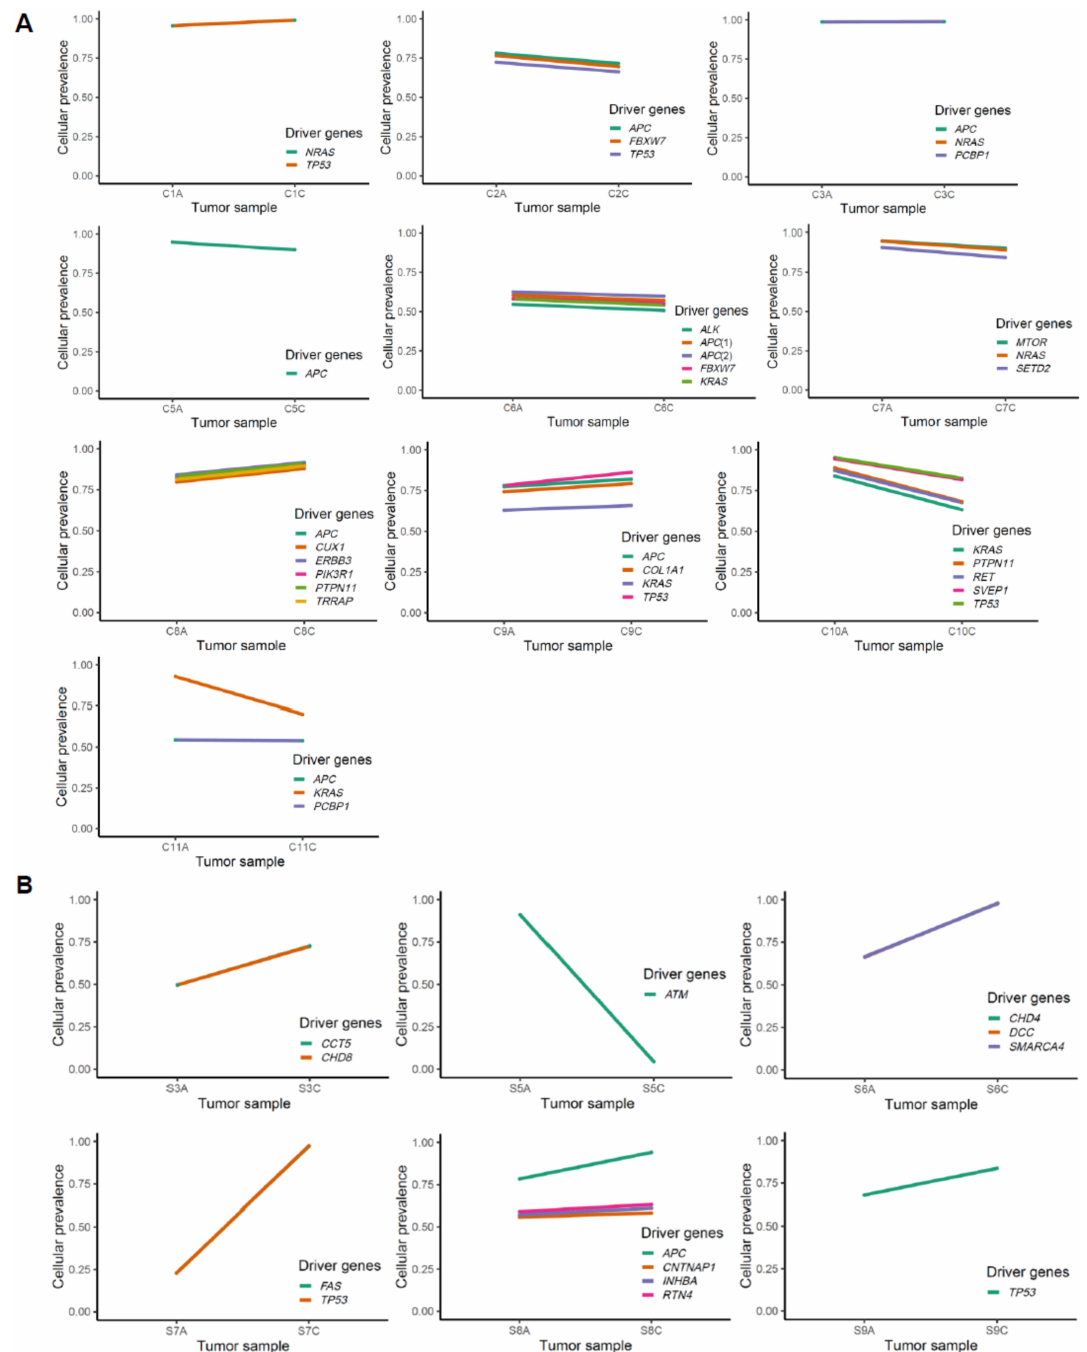
Figure 4. Cellular prevalence of mutation clusters using PyClone between adenoma and carcinoma pairs. ( A ) and ( B ) show the inferred cellular frequency of mutation clusters containing driver mutations in colorectal and gastric samples, respectively. The annotated genes (right) indicate the lesion-common mutated driver